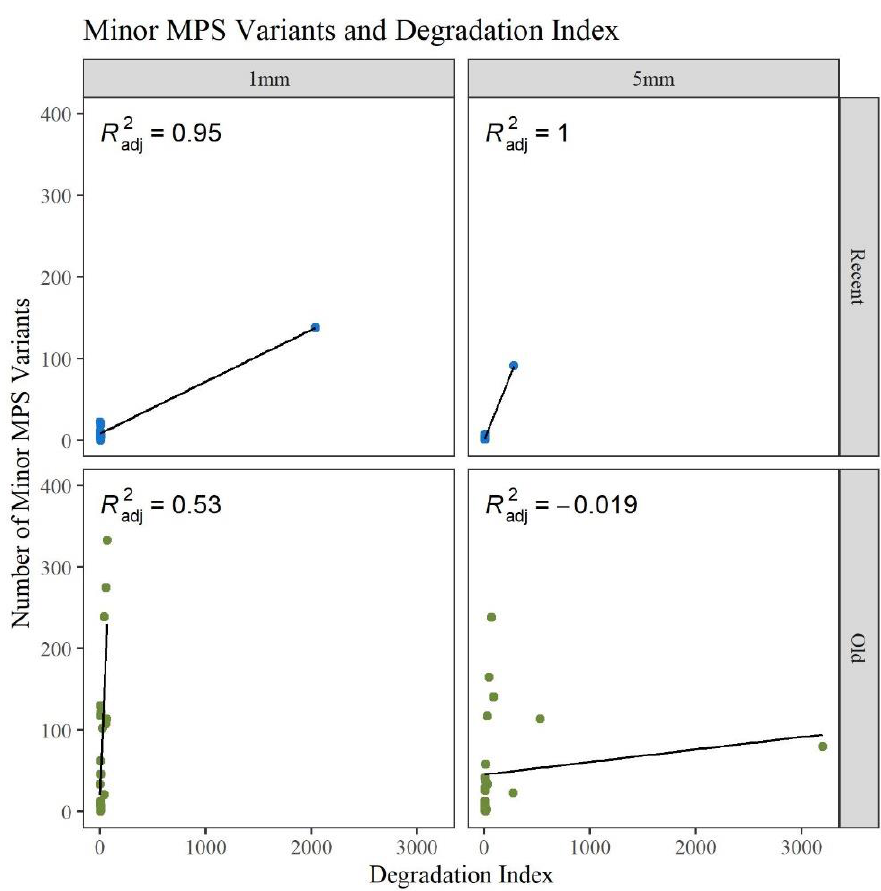
Figure 5. Linear regression of the number of reported minor MPS variants compared to the calculated degradation index for each age group and length (n = 74; n R = 26, n O = 48).